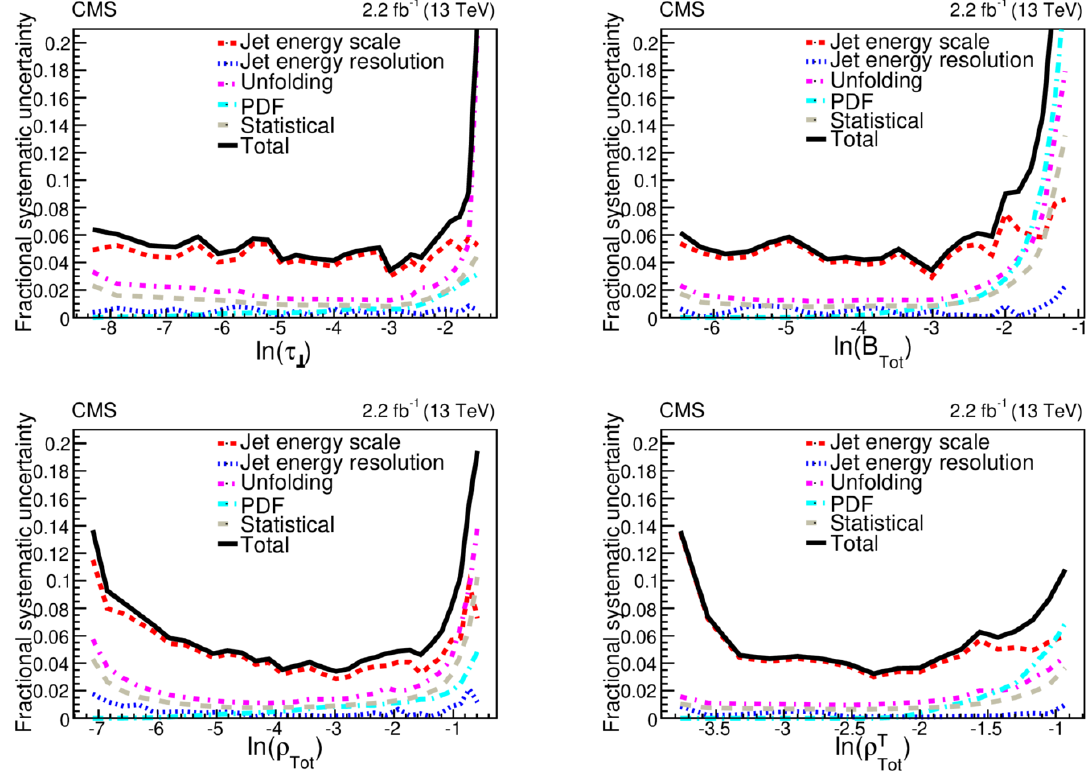
Figure 1 . Total uncertainty (black line) for the four event shape variables: the complement of transverse thrust ( (cid:28) ? ) (upper left), total jet broadening ( B Tot ) (upper right), total jet mass ( (cid:26) Tot ) (lower left) and total transverse jet mass ( (cid:26) T ) (lower right) evaluated with jets for 225 < H T ; 2 < Tot 298 GeV. The contributions from di(cid:11)erent sources are also shown in each plot: JES (red dashed line), JER (blue dotted line), unfolding (pink dash-dotted line), PDF (light-blue dash-dotted line) and statistics (grey dashed